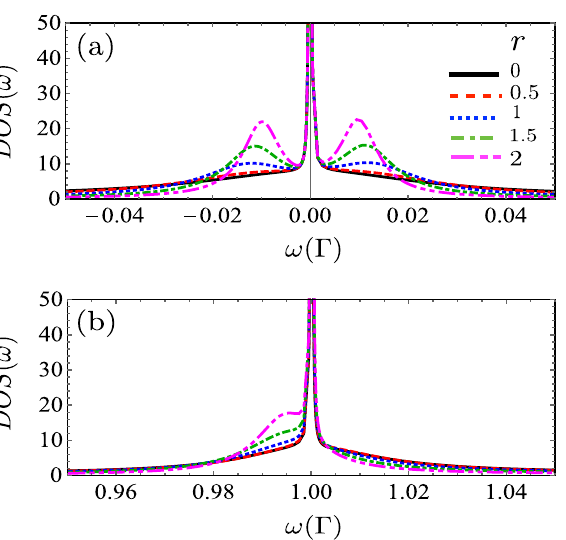
1 Ŵ ), when ǫ d 0 is = = 0.001 Ŵ , =